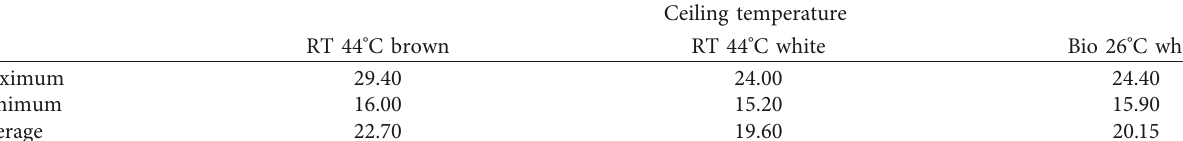
Table 13: Ceiling temperature measurements of Test 2 ( ° C).